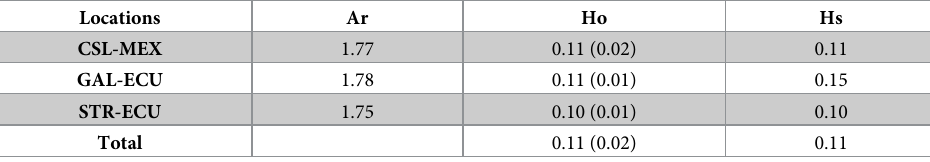
Table 1. Summary of genetic diversity statistics for each sampling area of yellowfin tuna.